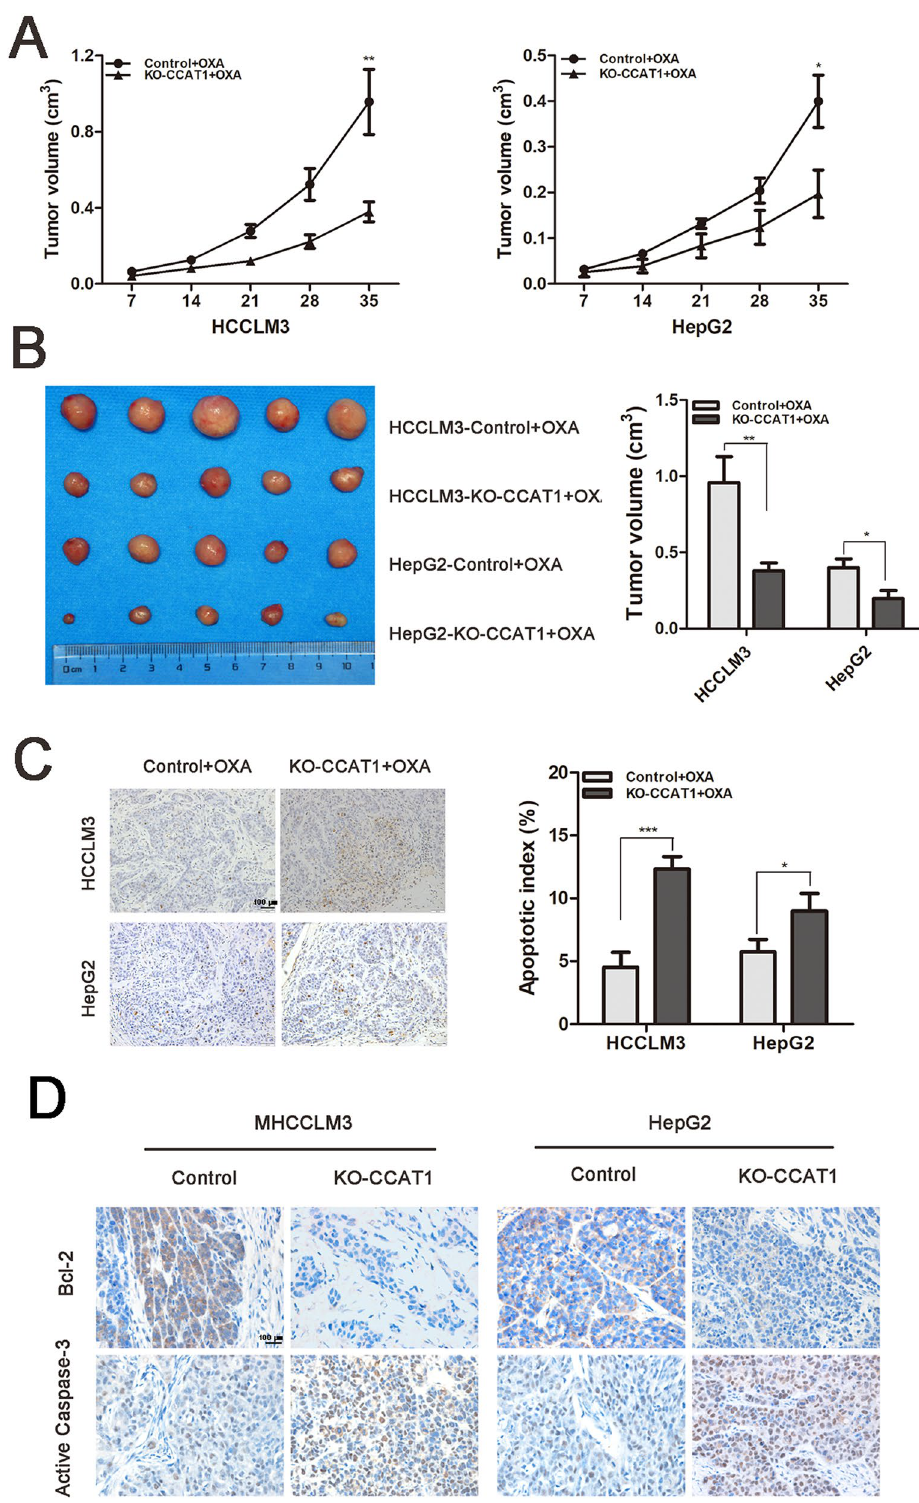
Figure 2. CCAT1 involved in HCC resistance to oxaliplatin in vivo . All groups received intraperitoneal injections of OXA (0.8 mg/kg/w). ( A ) Tumor growth curves of subcutaneous implantation models of HCC. ( B ) The average tumor volumes were calculated using the following formula: V(mm 3 ) = (L × W 2 ) × 0.5 (L: tumor length, W: width). ( C ) TUNEL assay was applied to detect HCC apoptosis in subcutaneous implantation tumor (Original magnification: × 200). ( D ) Immunohistochemistry staining for Bel-2 and active caspase-3 expressions in subcutaneous tumor (Original magnification: × 400). * P < 0.05, ** P < 0.01, *** P <